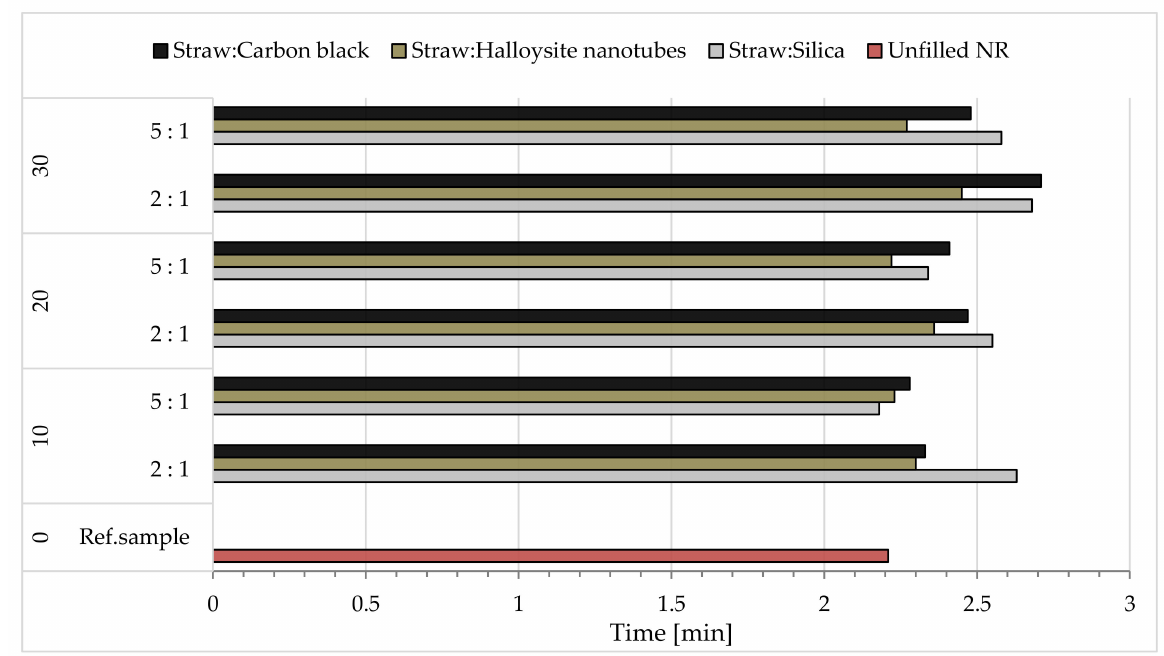
Figure 11. The optimal curing time of rubber